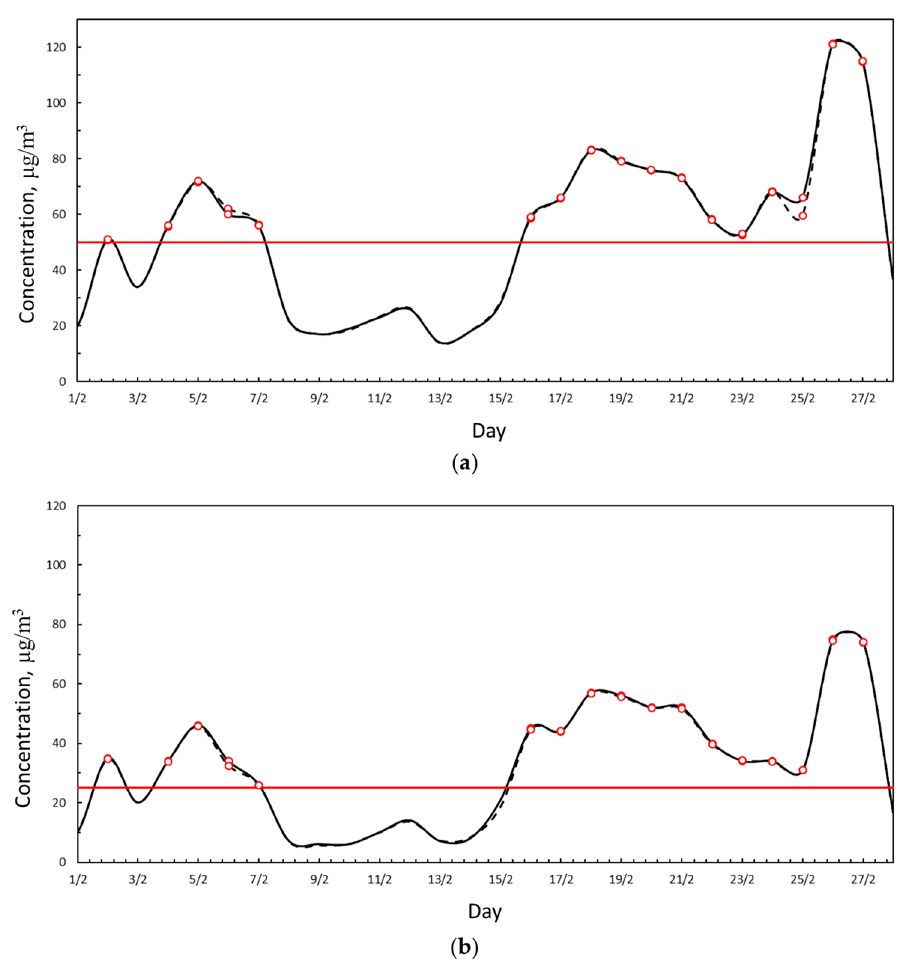
Figure 3. ( a ) PM10 daily average concentration measured at the VC station with gravimetry (solid black line) and with laser scattering (dashed black line). Red line represents the legal limit concentration according to D.Lgs. 155/2010. Red dots represent exceedance of the legal limit. ( b ) PM2.5 daily average concentration measured at the VC station with gravimetry (solid black line) and with laser scattering (dashed black line). Red line represents the legal limit concentration according to D.Lgs. 155/2010. Red dots represent exceedance of the legal limit.